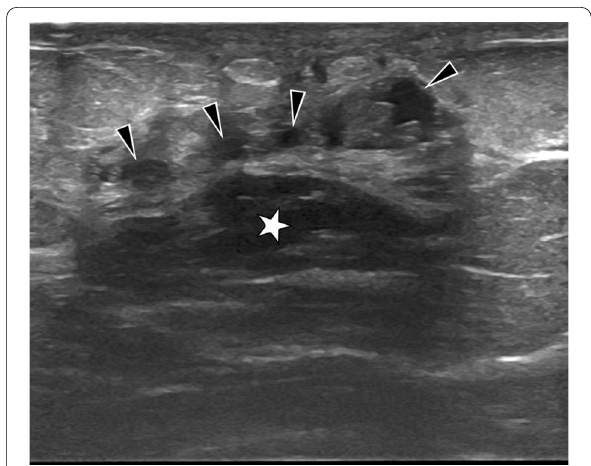
Fig. 8 A 46-year-old female with PCR (polymerase chain reaction) proven tuberculosis in the left breast. Gray-scale ultrasound image shows multiple abscesses (arrowheads) and a hypoechoic, oval mass with circumscribed margins (star). BIRADS 4